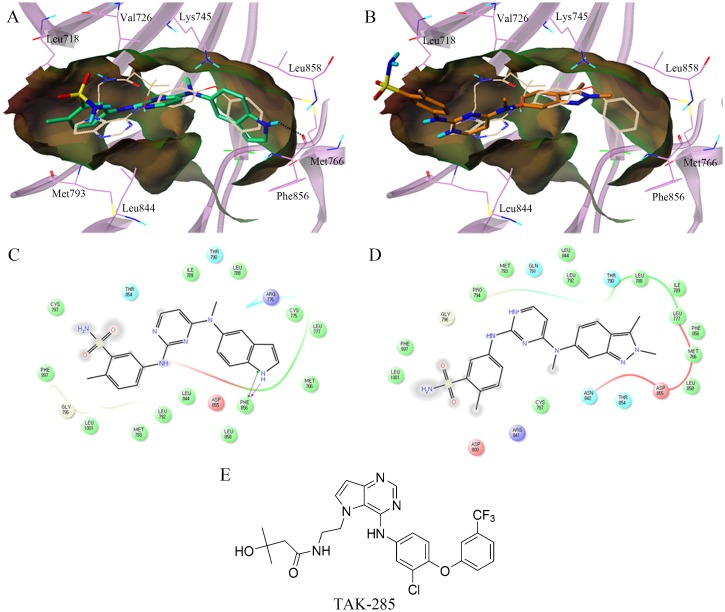
Predicted docking orientation of MKP101 in the epidermal growth factor receptor (EGFR) kinase domain.The binding poses of (A) MKP101 (carbon atoms in green) and (B) pazopanib (carbon atoms in orange) in the human EGFR kinase domain were compared. The structure of co-crystallized TAK-285 is shown as a reference (carbon atoms in off-white). Hydrogen bonds are displayed as dashed lines. The lipophilic potential surface of the ATP-binding site of EGFR was created using the MOLCAD implemented in Sybyl-X 2.0. A 2D-interaction diagram of the binding model of (C) MKP101 and (D) pazopanib was generated, which displayed amino acid residues within 4.0 Å of the ligand. Acidic, hydrophobic, basic, polar, and other residues at the active site are represented by red, green, purple, blue, and gray spheres, respectively. Hydrogen bonds between the ligand and the backbone are shown in dashed pink lines. The π-π stacking interaction is shown with a green line. The docking models show that MKP101 occupies the ATP-binding site in a manner similar to TAK-285, and the indole ring of MKP101 interacts with the backbone of the Phe856 by hydrogen bonding. However, as expected, pazopanib did not fit well at the ATP binding site. 2D, 2-dimensional; ATP, adenosine triphosphate.